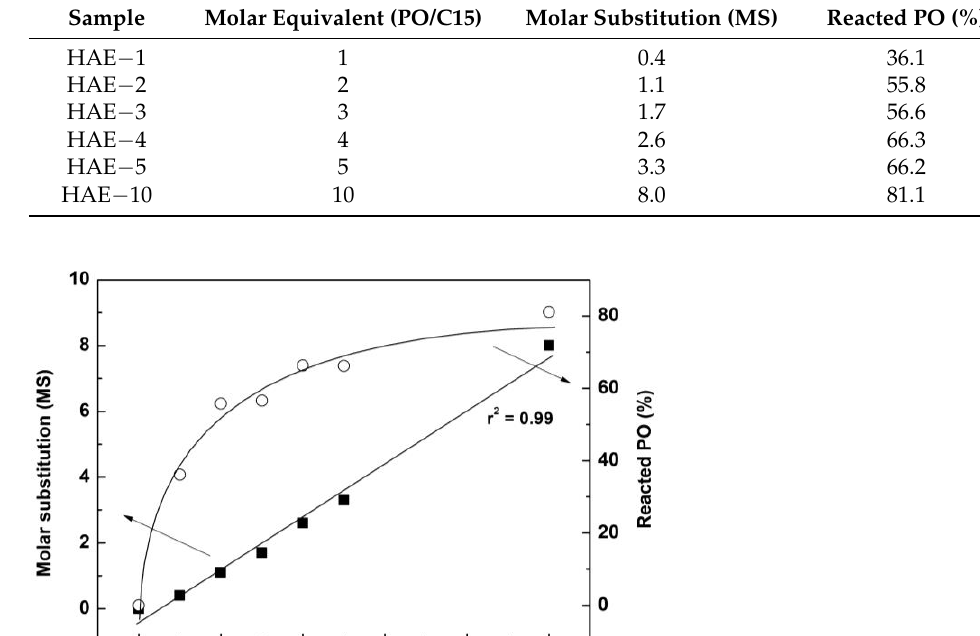
Table 2. Result of molar equivalent, molar substitution (MS), and reacted PO of HAEs. Sample